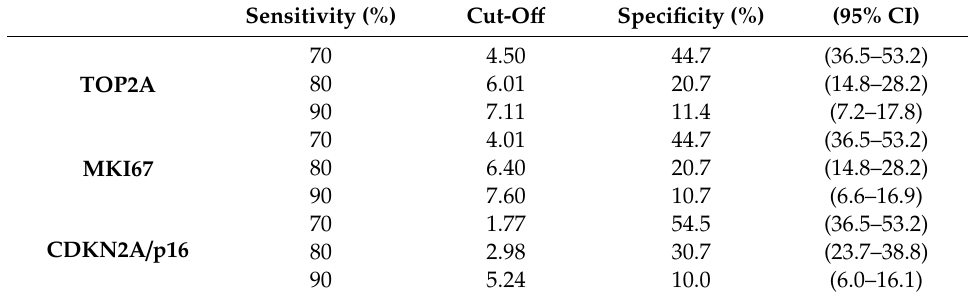
Figure 2. ROC curves and the area under curve for the identification of patients with HSIL/AIN2–3. mRNA levels are presented as ΔΔ Ct [(cycle threshold target-cycle threshold reference sample) − (cycle threshold SiHa-cycle threshold reference SiHa)]. The values of the areas under the ROC curve (AUC) and the 95% confidence intervals (95% CI) are presented. ( a ) TOP2A; ( b ) MKI67; ( c ) CDKN2A/p16. Table 3. Cut-off values and specificity of TOP2A, MKI67 and CDKN2A/p16, for the diagnosis of histologically confirmed high-grade squamous intraepithelial lesion (HSIL/AIN2–3) for sensitivity established at 70%, 80% and 90%.